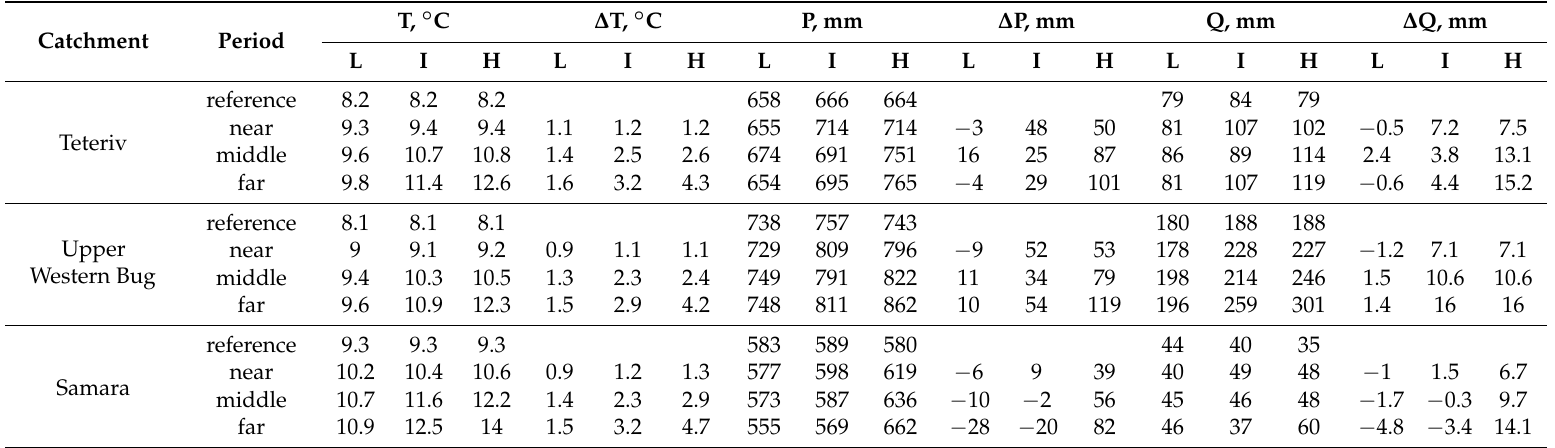
Table 2. The long-term average temperature, precipitation and river discharge: absolute values in four periods and delta changes in the scenario periods related to the reference period for the three catchments under study.